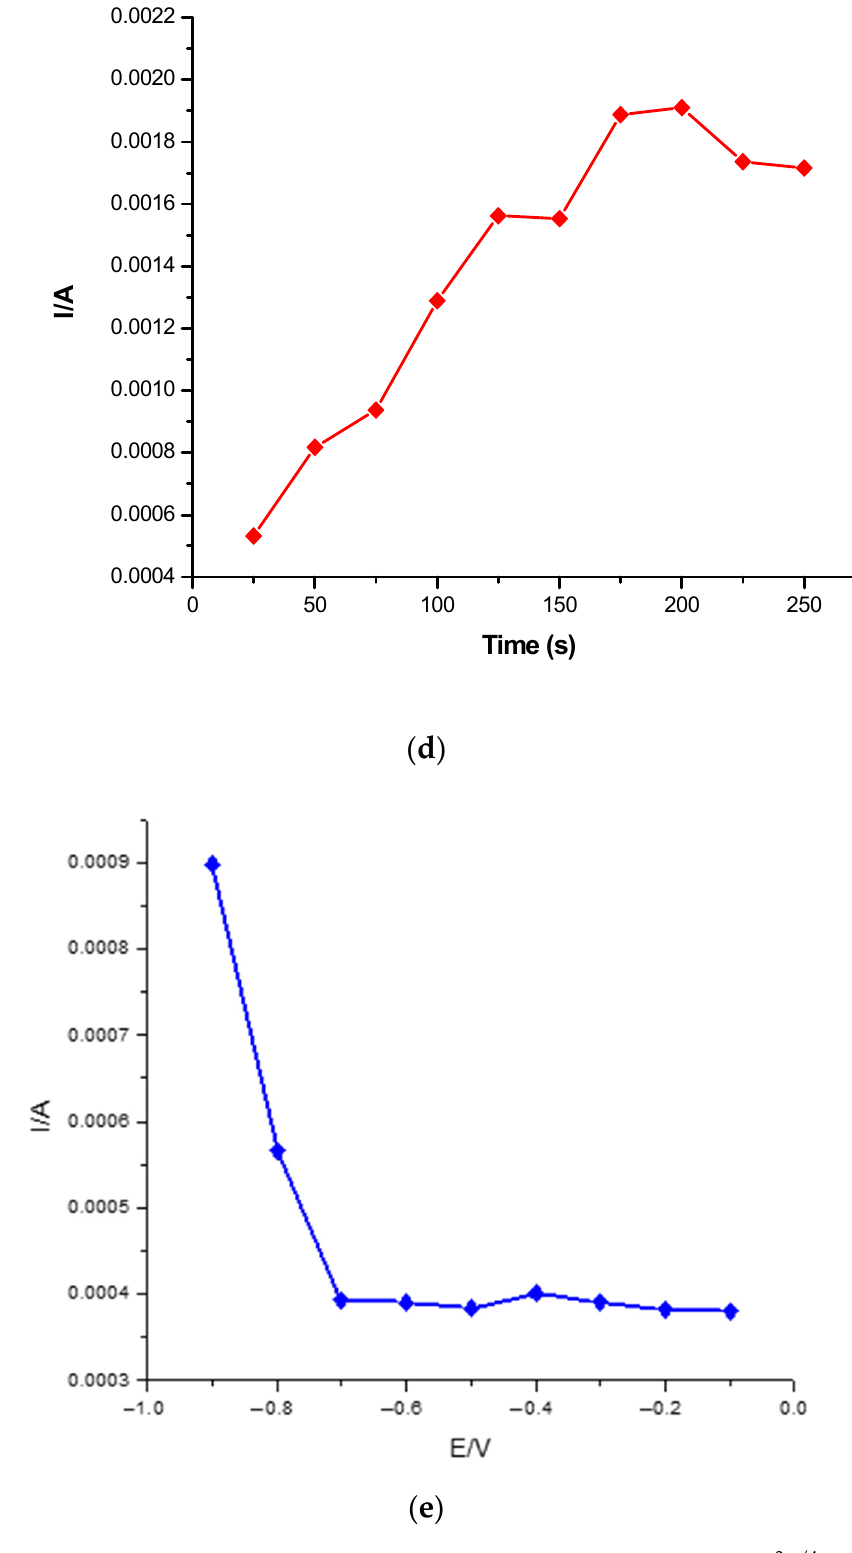
Figure 8. ( a ) Cyclic Voltammetry multi-scan of bare GCE in 10 mM [Fe(CN) 6 ] 3 − /4 − redox probe and optimization of: ( b ) electrolytes, ( c ) pH ( d ) deposition time, and ( e ) deposition potential.